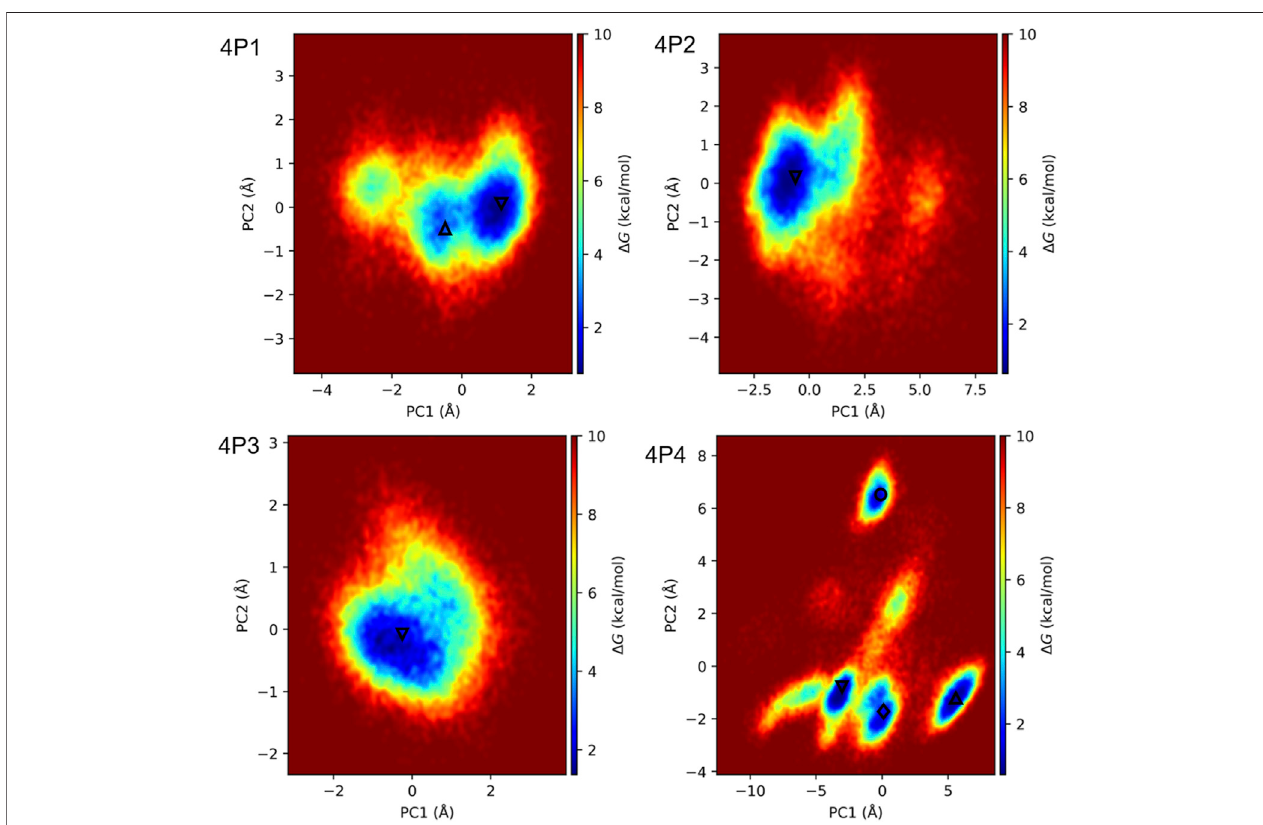
FIGURE6| FELheatmapsfor3CL pro incomplexwith4P1,4P2,4P3,and4P4.FELswereobtainedbyprojectingtheconcatenatedreplicate1 μ strajectoriesofthe complexes onto PC1 and PC2, associated with the motions of the D-peptide C α atoms. All trajectories were fi tted to the respective initial structures with respect to the backbone atoms of 3CL pro in the ChT-like domains. The local energy minima observed in the heatmaps are indicated with the symbols Δ , ∇ , ◊ , and ○ , which rank the minima accordingtotheirrelativesizesindecreasing order( Δ > ∇ > ◊ > ○ ).PC1 and PC2 werechosentogenerate FELS becausethey accountfor morethan 68% of the motions of the D-peptide C α atoms in all cases ( Supplementary Figure S10